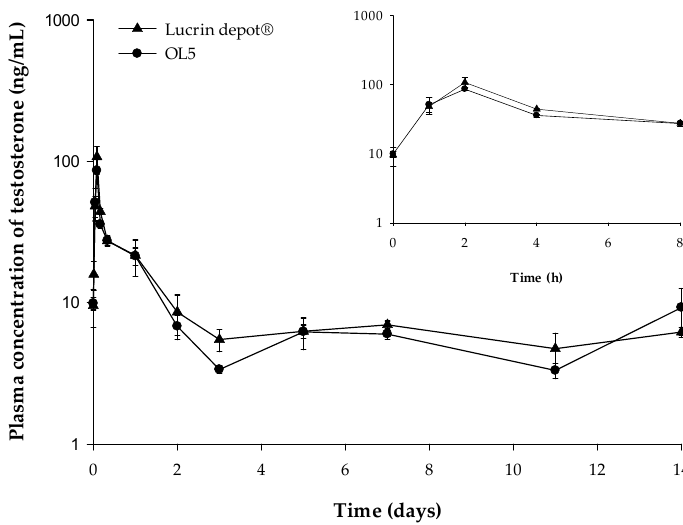
Figure 7. The pharmacodynamic profiles after subcutaneous (SC) administration of Lucrin depot ® or OL5 in rats. The inset shows the short-term pharmacodynamic (PD) profile up to 8 h (mean ± SE, n = 5).